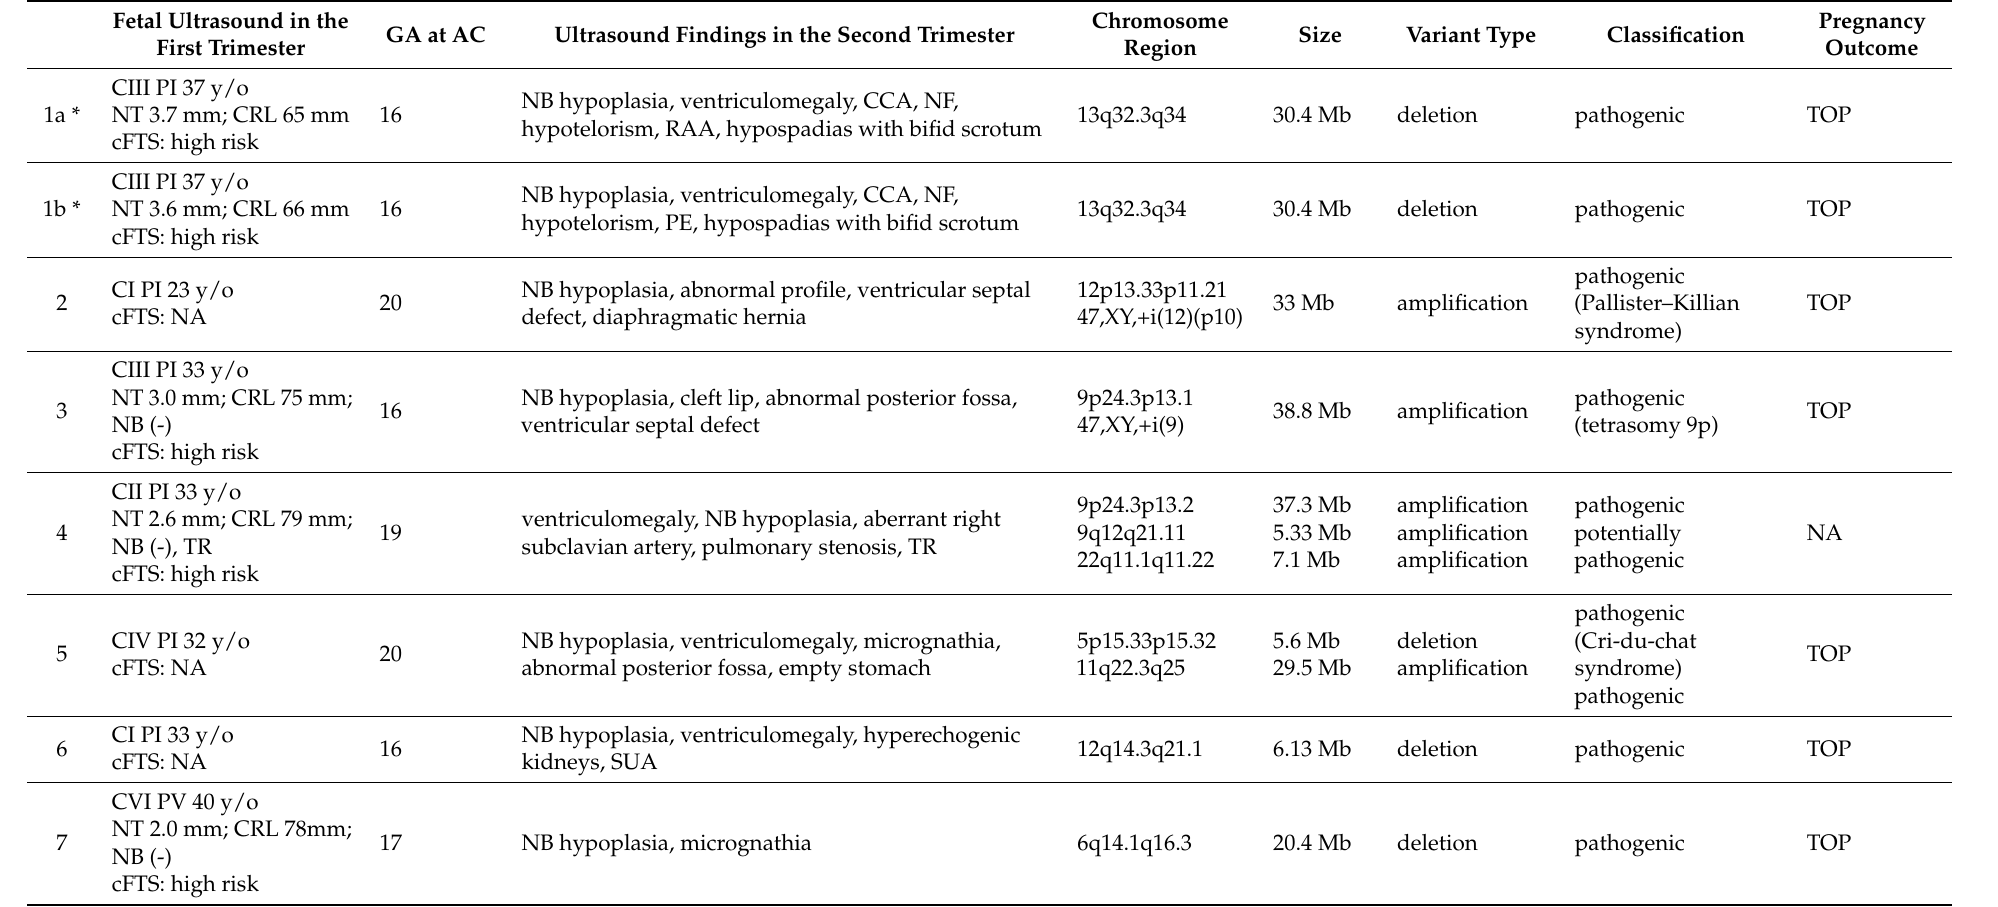
Table 3. Cases with nasal bone hypoplasia and concomitant fetal